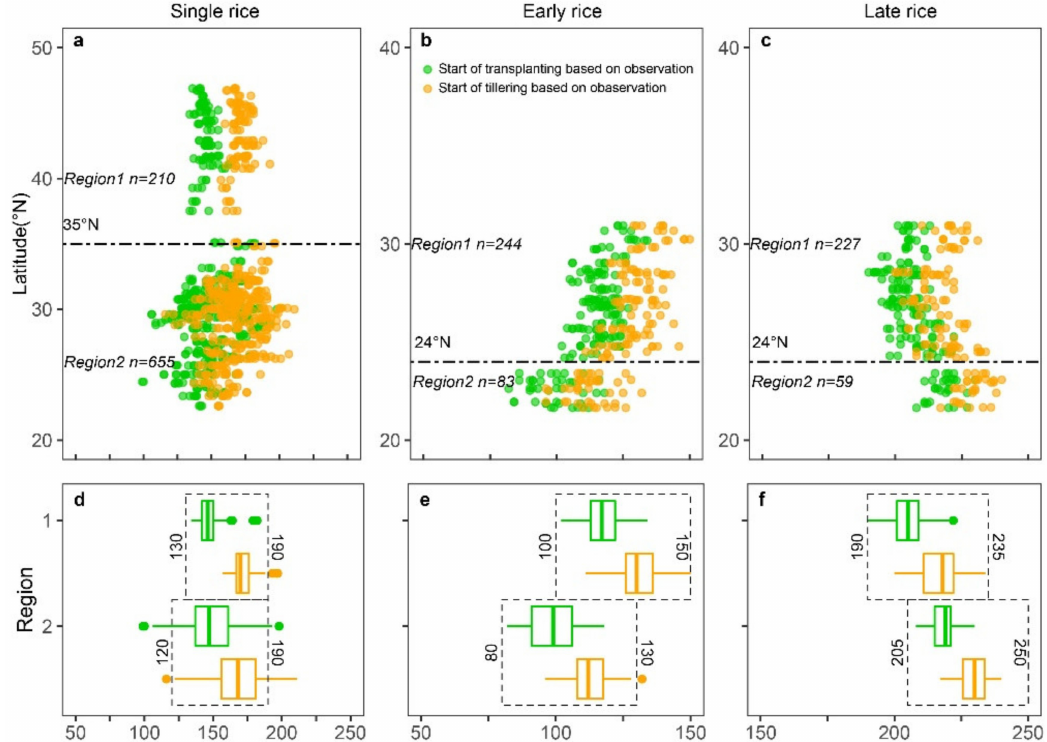
Figure 2. Distribution of in situ observed transplanting and tillering dates of ( a ) single rice, ( b ) early rice, and ( c ) late rice. The areas with single rice, early rice, and late rice are divided into two regions by the 35 ◦ N, 24 ◦ N, and 24 ◦ N latitude lines respectively. The flooding and rice transplanting windows of single rice ( d ), early rice ( e ), and late rice ( f ) were identified according to observations ( a – c ). The numbers near the black dashed boxes show the start and end dates of the flooding and rice transplanting windows according to in situ observed phenology data for